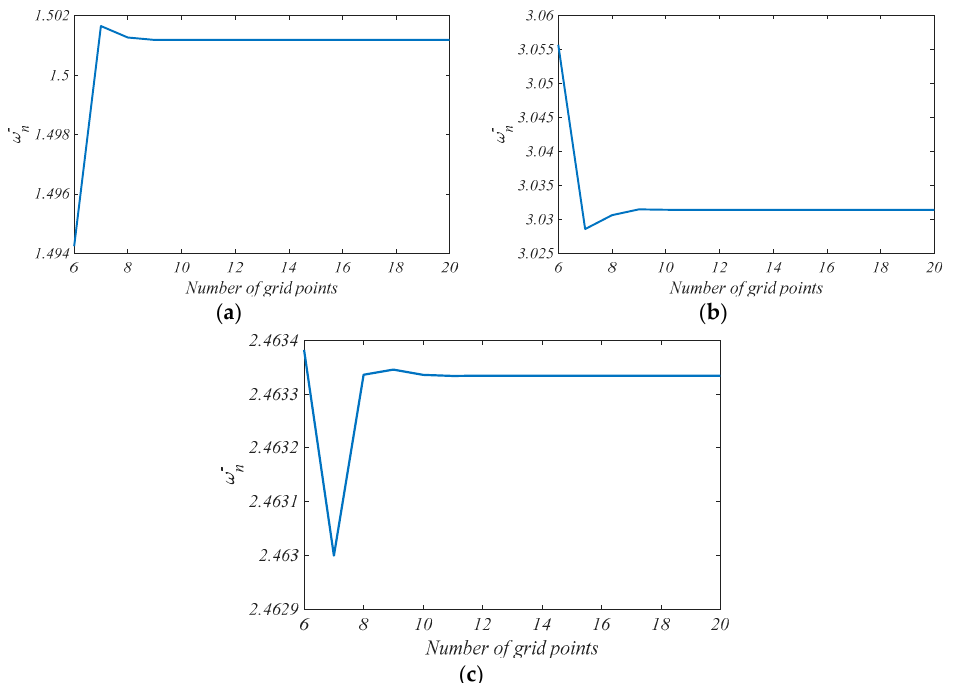
Figure 5. Convergence of nondimensional natural frequency of MHCAP with b/a = 4, h/b = 0.1, T i = 273 [K], T o = 300 [K], weight fraction of CNT (W CNT = 0.02), volume fraction of carbon fiber (V F = 0.2), θ = π /4, UTR, β = 1, FG-A, K w = 0 [M N/m 3 ] and K p = 0 [M N/m] for various boundary conditions. ( a ) Simply-Simply; ( b ) Clamp-Clamp; ( c ) Clamp-Simply.